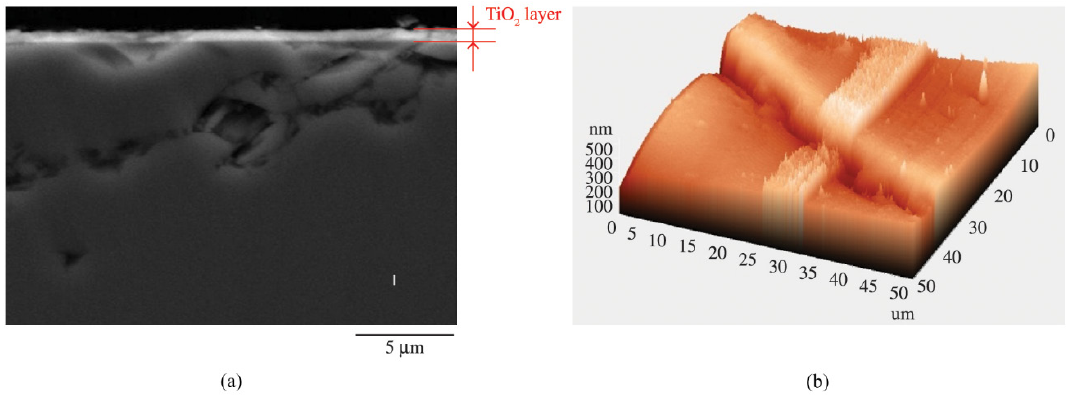
+ 06 sccm Ar + 03 sccm O . Samples 2 2 + 03 sccm Ar + 03 sccm O 2 2